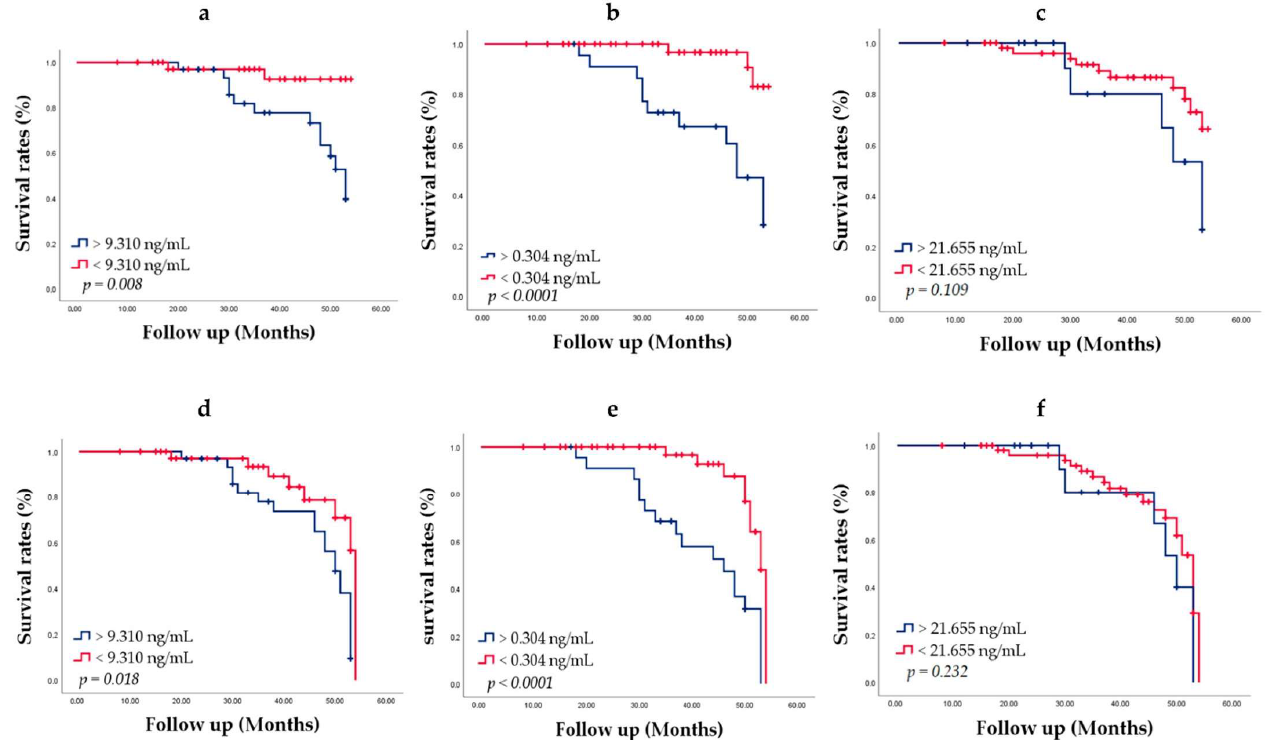
Figure 7. Overall survival according to death: impact of ( a ) HSP27, ( b ) Menin and ( c ) PSA on concentrations (ng/mL) PCa-specific survival. Overall survival according to metastasis: impact of ( d ) HSP27, ( e ) Menin and ( f ) PSA concentrations (ng/mL) on PCa-specific survival. Cut-offs HSP27, Menin and PSA were 9.310, 0.304 and 21.655 ng/mL, respectively. p -values were calculated by using the Log Rank